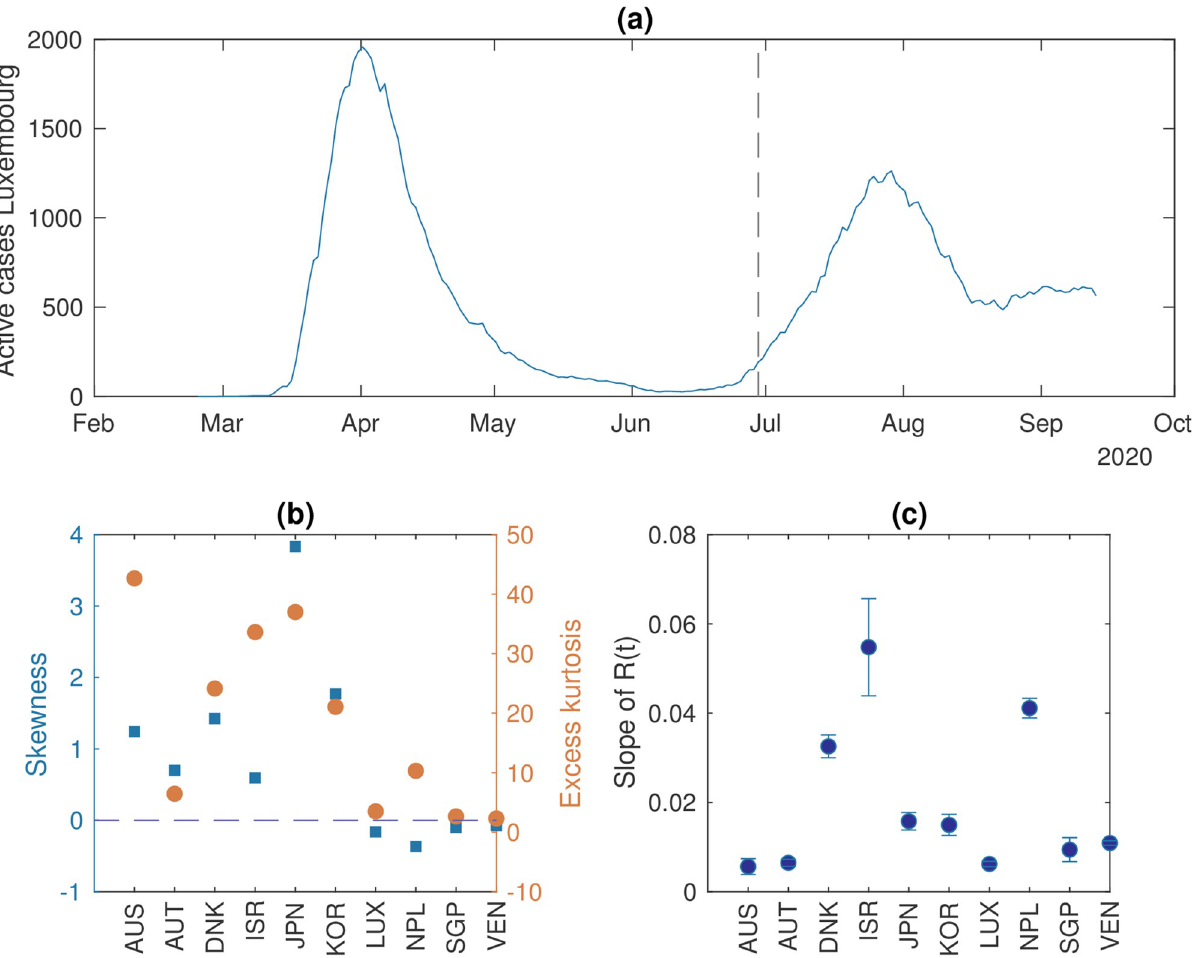
Fig 1. Analysis of the dynamical characteristics of the countries included in the data set. A: An example of an epidemiological curve of active cases from Luxembourg. The dashed line indicates the transition, measured by R > 1. The latter is objectively identified by the date at which the probability of R ( t ) to be greater than 1 is at its first maximum (see “Analysis of dynamical features”). B: Measures of the distribution of data fluctuations. Skewness μ indicates the symmetry of the distribution, whereas kurtosis γ indicates the relevance of its peak with respect to the tails. Large deviations from μ = 0 (dashed line) and γ = 3 are associated with non-normal distributions, so we display the excess of kurtosis γ − 3. C: The regression coefficient of R ( t ) and its associated uncertainty, as obtained from the linear fit Eq